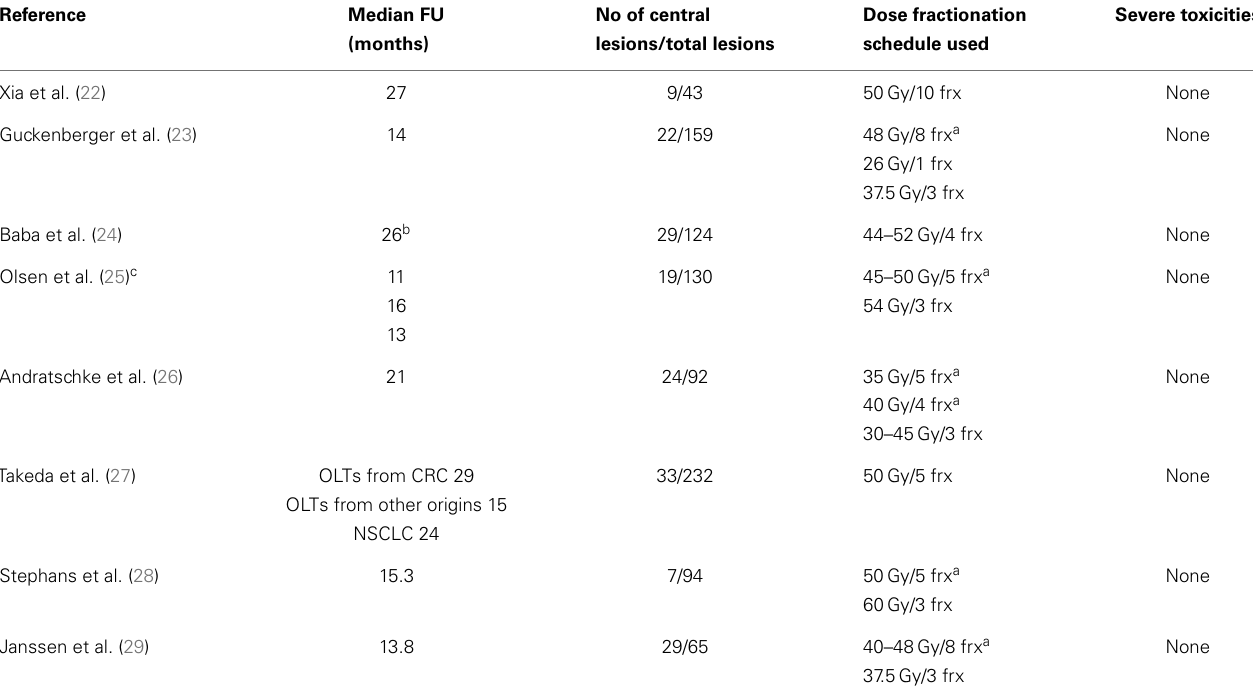
Table 4 | Studies on lung SABR reporting no severe toxicity associated with central location